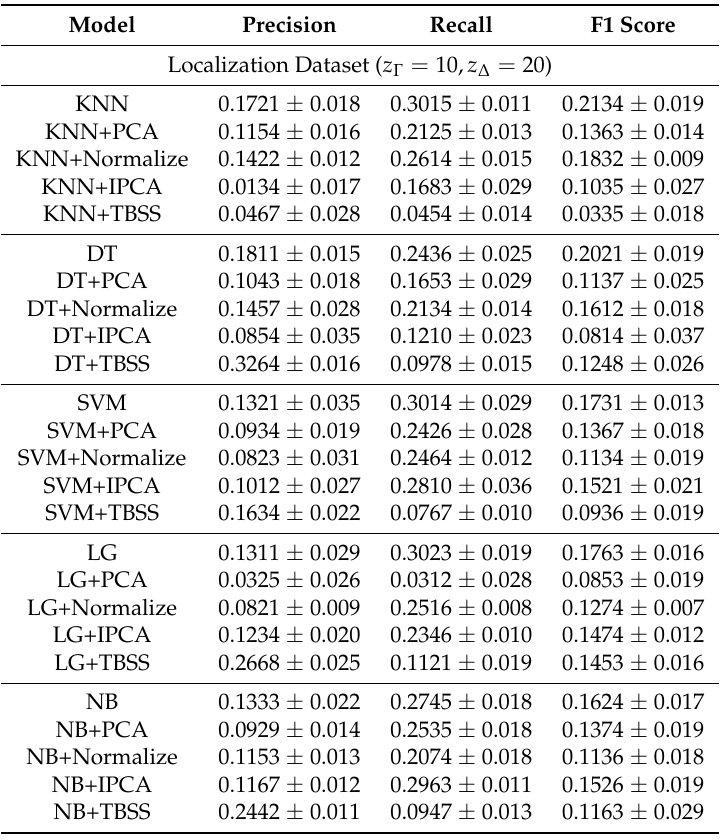
Table 2. The performance of TBSS and other pre-processing methods on localization recognition